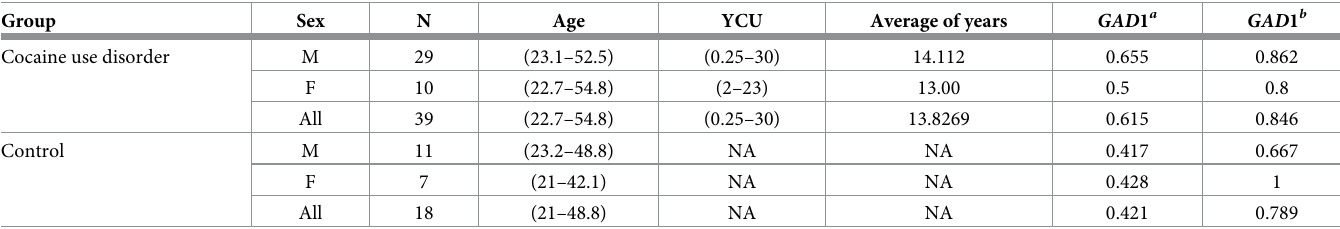
N: sample size, Age and Years of use Cocaine: range in years, YCU: Years of cocaine